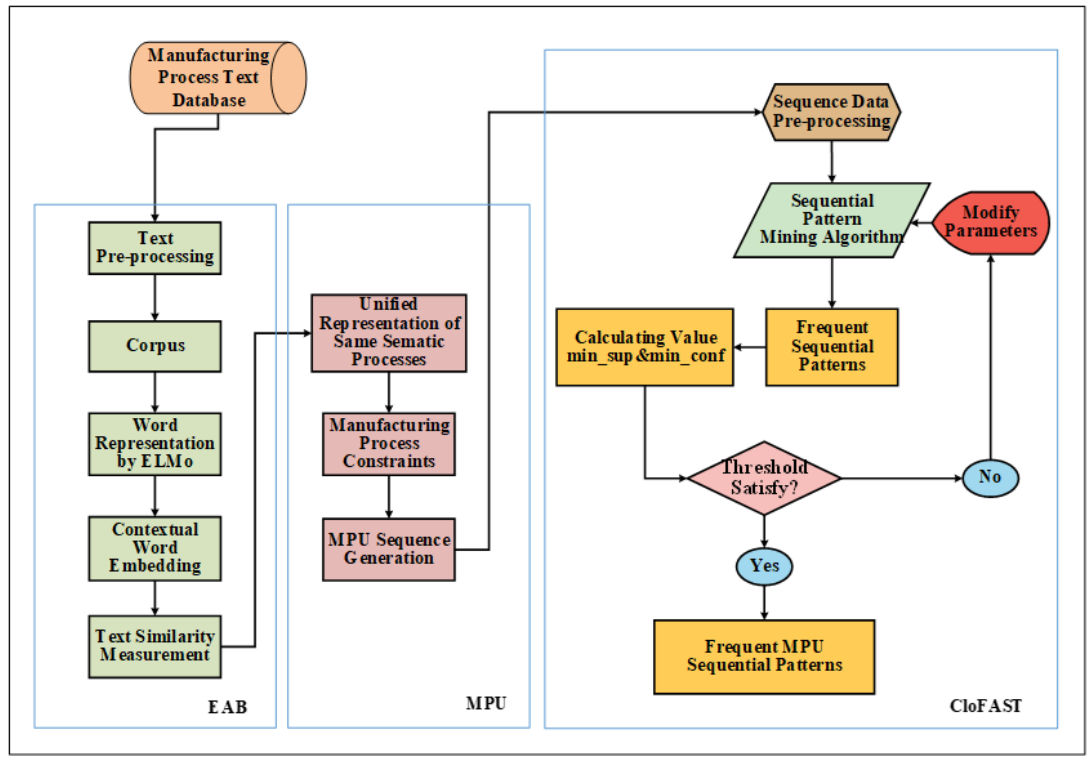
Figure 6. EABMC sequential patterns mining model.